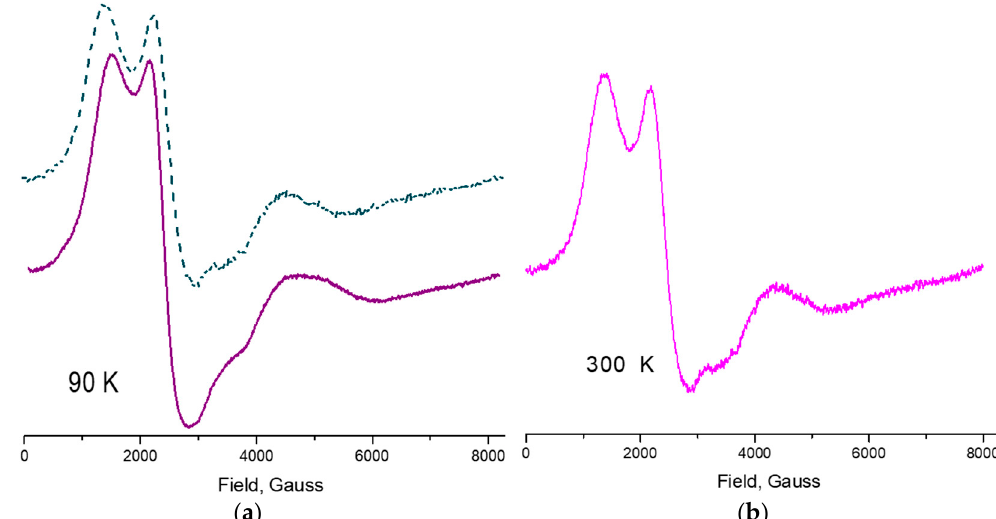
Figure 5. ( a ) ESR spectra of 1 at 90 K and ( b ) at 300 K, showing Mn(II), Mn(III) and Mn(IV) with different spin states. Simulation of the spectrum at 90 K, green dashed line, gave g values of 4.48, 1.87 for Mn(IV) high spin s = 3 , 2.76 characteristic of Mn(II) low spin s = 1 and 1.55 which corresponds to Mn(III) low spin s = 1.